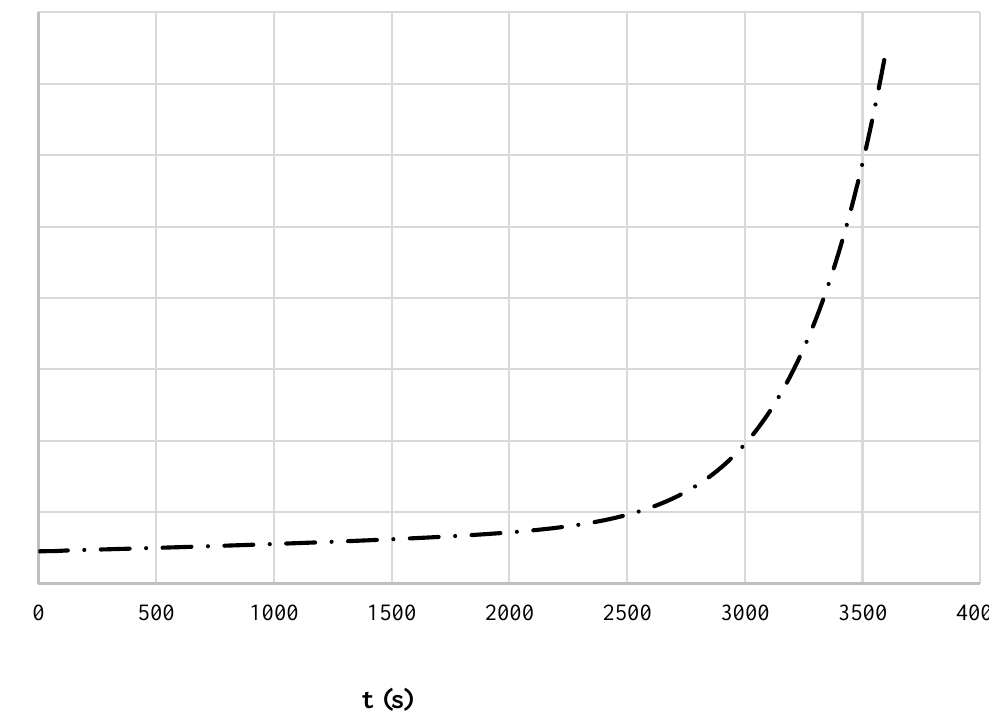
Figure 6. Water mole fraction in the output stream in natural gas with